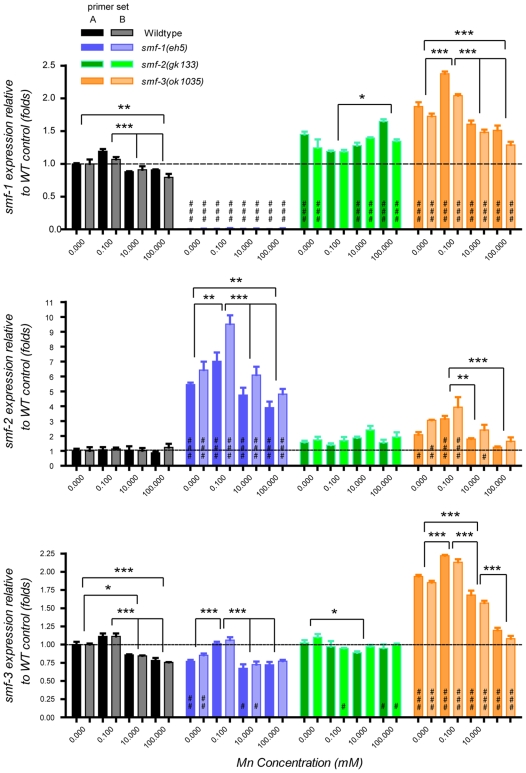
Genotype and Mn exposure influence on smf gene expression.Both independent primer sets corresponding to the 3′ end of the cDNA and used to assess smf gene expression (set A bright colors, and set B faded colors) give consistent results (A, B, C). smf-1 and smf-3 mRNA levels display similar variations, increasing at low Mn exposure (0.1 mM) and decreasing upon high Mn concentrations (10 mM and 100 mM) in WT, smf-1 and smf-3 mutants (A, C, black, blue, orange). smf-2 mRNA levels follow the same tendency in smf-1 and smf-3 mutants but are not affected by Mn exposure in WT (B). Independent of Mn exposure, smf-1(eh5) mutant is characterized by a strong up-regulation of smf-2 expression (B, blue). Compared to other genotypes, smf expression in smf-2(gk133) does not appear to correlate with Mn exposure (A, B, C, green). The smf-3(ok1035) mutant exhibits higher smf gene expression levels regardless of Mn exposure dose (A, B, C, orange). While # designate significant differences between genetic backgrounds exposed to the same manganese dose, * indicate significant differences between exposure doses within the same C. elegans strain: #/* p<0.05. ##/** p<0.01, ###/p<0.001. Displayed significance levels between treatments reflect the weakest significance score obtained between both primer sets.